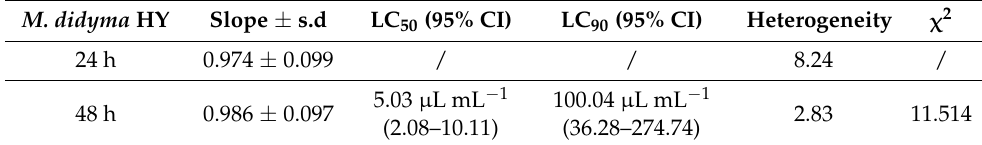
Table 1. Contact LC 50 and LC 90 for M. didyma HY against D. suzukii adults. LC 50 and LC 90 values are means plus 95% confidence interval. Bold indicates the LC 50 value used in physiological and behavioural experiments.